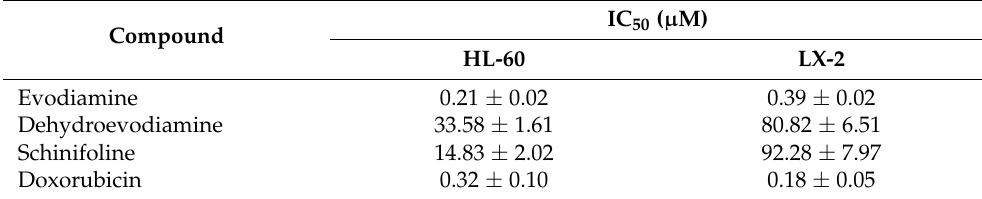
Table 3. Antiproliferative activity of the targeted compounds against HL-60 and LX-2 cells.